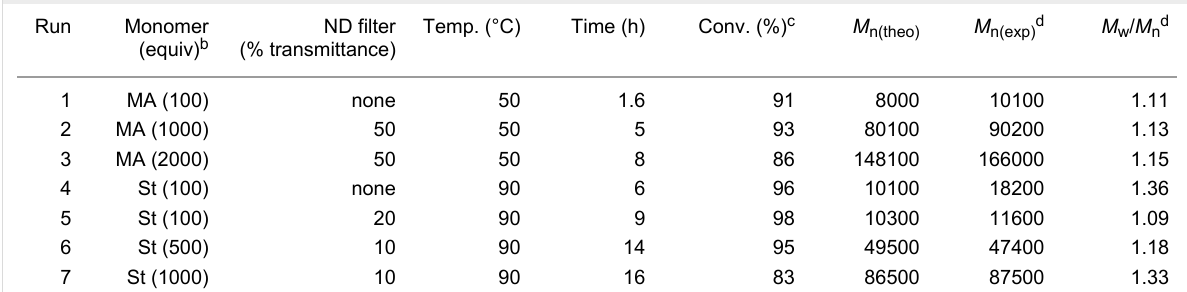
Table 2: Photopolymerization in the presence of 1 under LED irradiation.